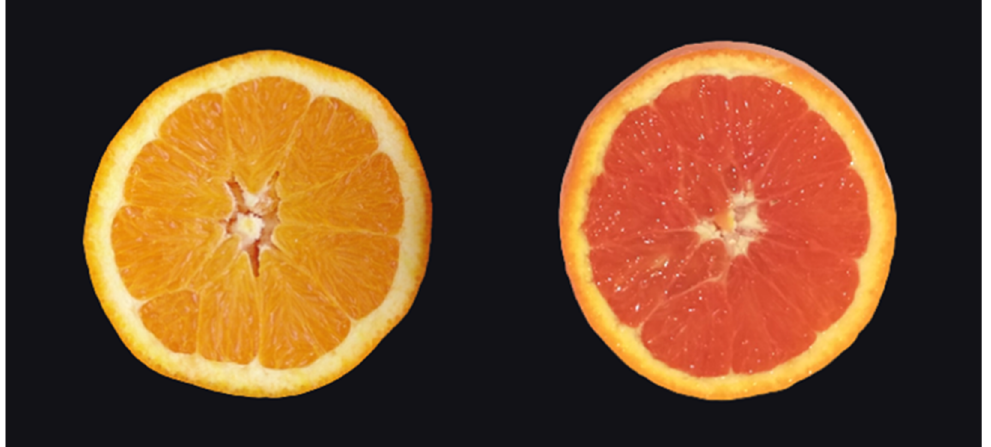
Figure 6. Fruit of “Cara Cara” ( right ) compared to the probable ancestor “Washington Navel” ( left ).